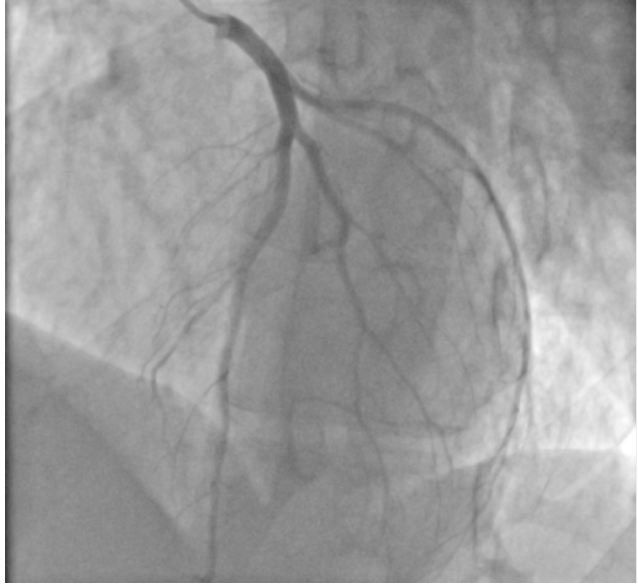
Figure 2. Coronary angiography (LAO cranial projection). There were no changes in the left main coronary artery, the left anterior descending and the circumflex arteries.